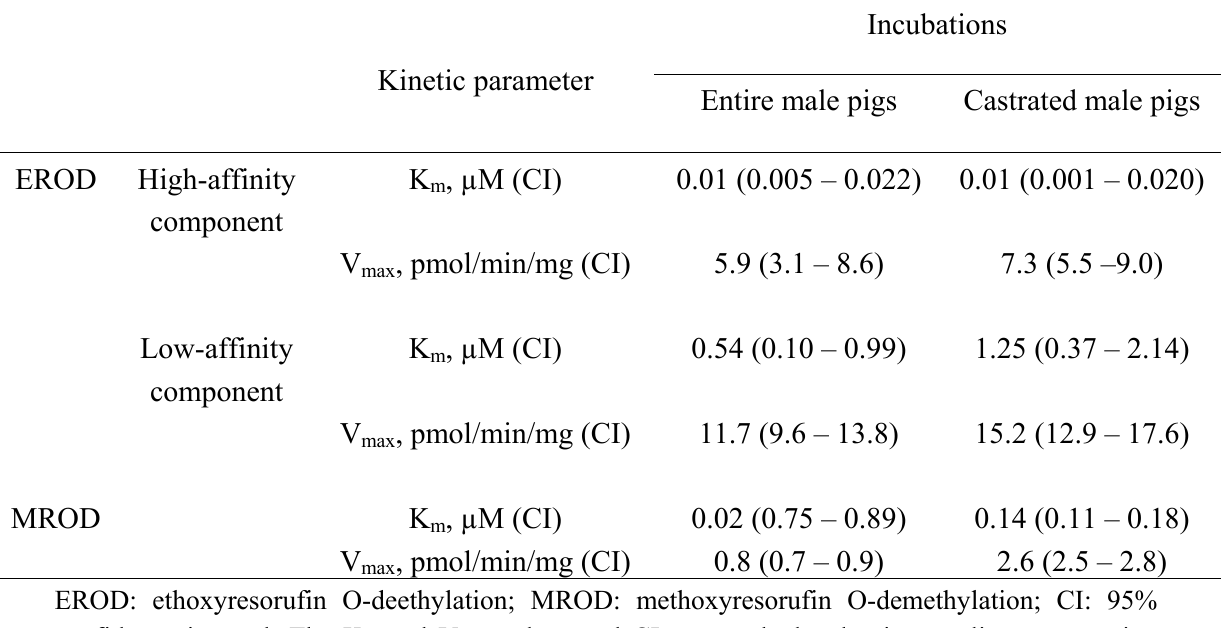
Table 3. Kinetic parameters of resorufin formation from 7-ethoxyresorufin and 7-methoxy- resorufin in the microsomes from entire male and castrated